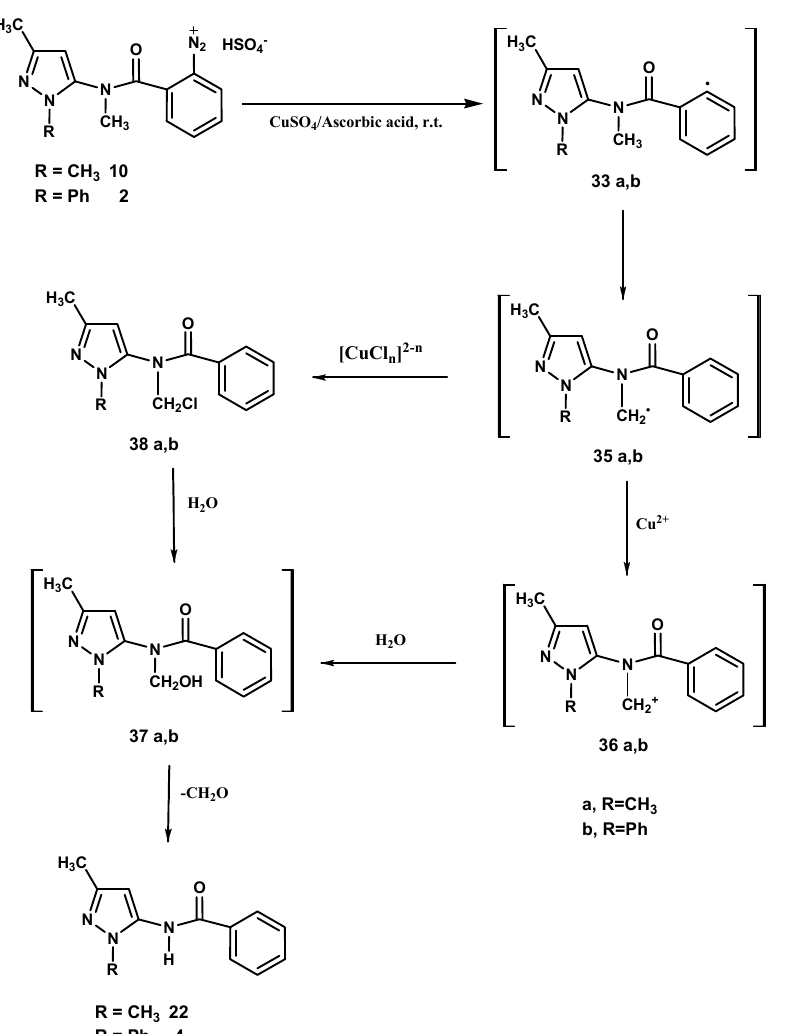
Scheme 5. 1,5-hydrogen atom transfer by -reaction in the transformation of diazonium salts 10 , 2 .